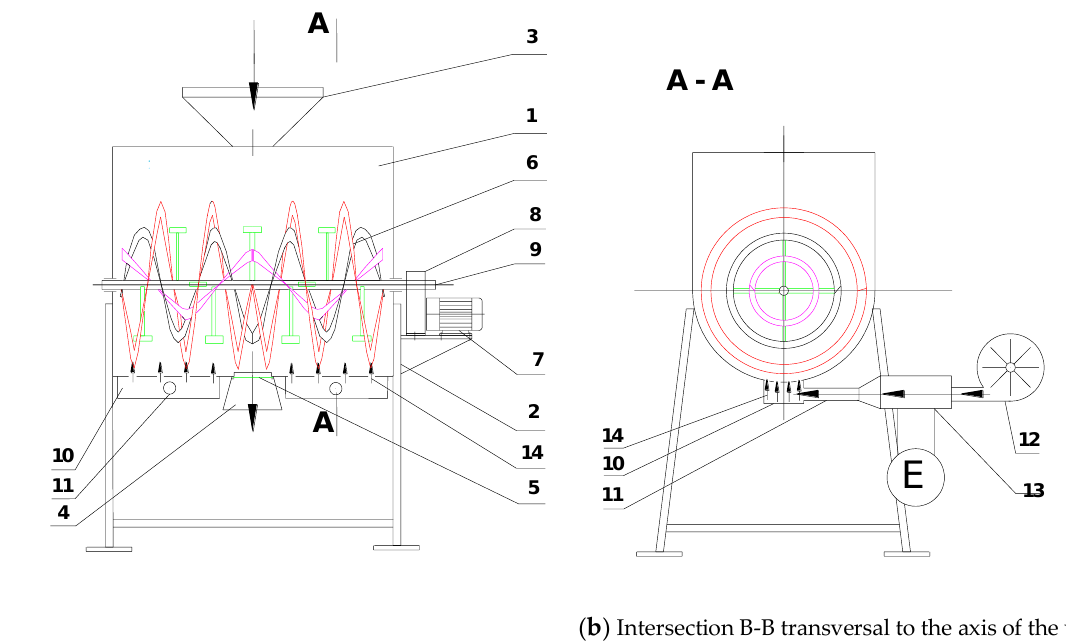
( b ) Intersection B-B transversal to the axis of the working as- ( a ) Intersection along the axis of the working unit. sembly with the presented connection unit of the blower with a heat exchanger at the bottom of the mixer-dryer tanker. Figure 5. Mixer-dryer for solid fraction separation: 1 — tank, 2 — rigid frame, 3 — charging hopper, 4 — outlet, 5 — gate valve, Figure 5. Mixer-dryer for solid fraction separation: 1—tank, 2—rigid frame, 3—charging hopper, 4—outlet, 5—gate valve, 6 — 3-ribbon mixing auger, 7 — engine, 8 — reduction drive, 9 — horizontal shaft, 10 — ventilation chambers, 11 — heater noz- 6—3-ribbon mixing auger, 7—engine, 8—reduction drive, 9—horizontal shaft, 10—ventilation chambers, 11—heater nozzle, zle, 12 — blower, 13 — heat exchanger, 14 — holes in the bottom of the tank, and E — electric power supply. 12—blower, 13—heat exchanger, 14—holes in the bottom of the tank, and E—electric power